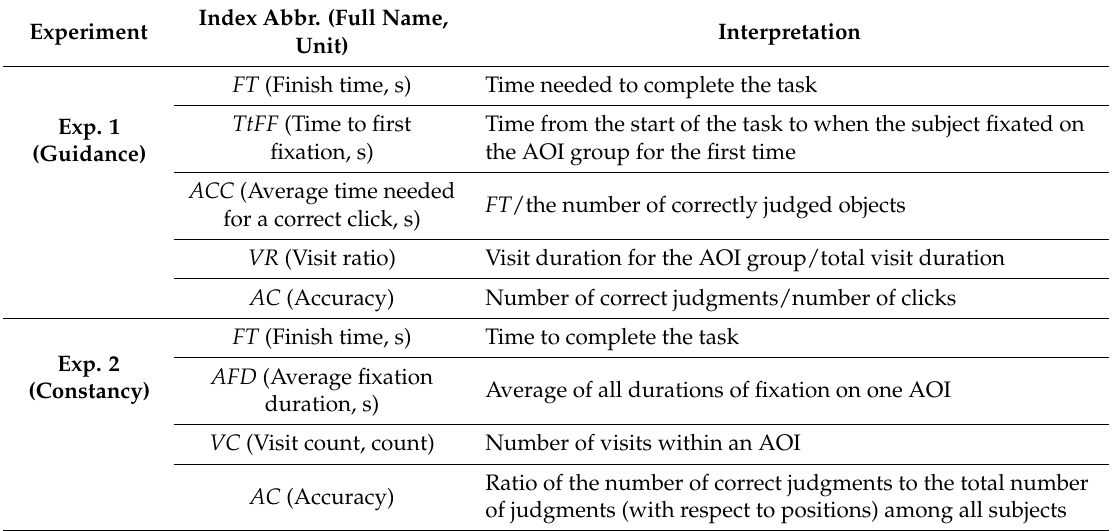
Table 2. Analysis indices and their